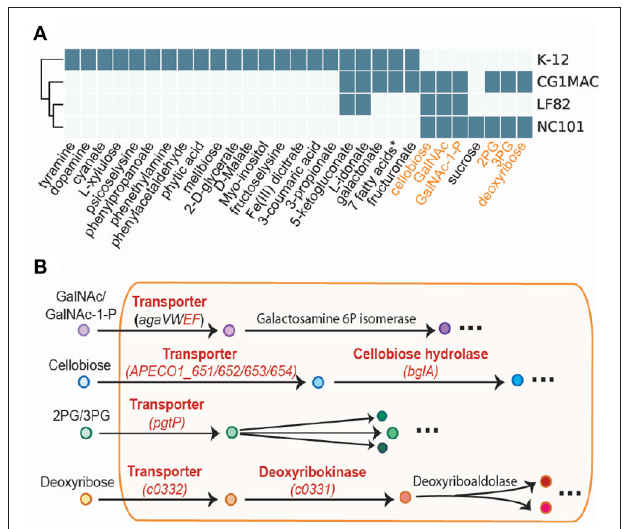
FIGURE 5 | Simulation results of four GEMs. (A) Growth capabilities on various nutrient sources can be used to differentiate between strains. (B) The key pathways involved in the capability to catabolize the six highlighted substrates. Enzymes in red are missing from E. coli K-12.